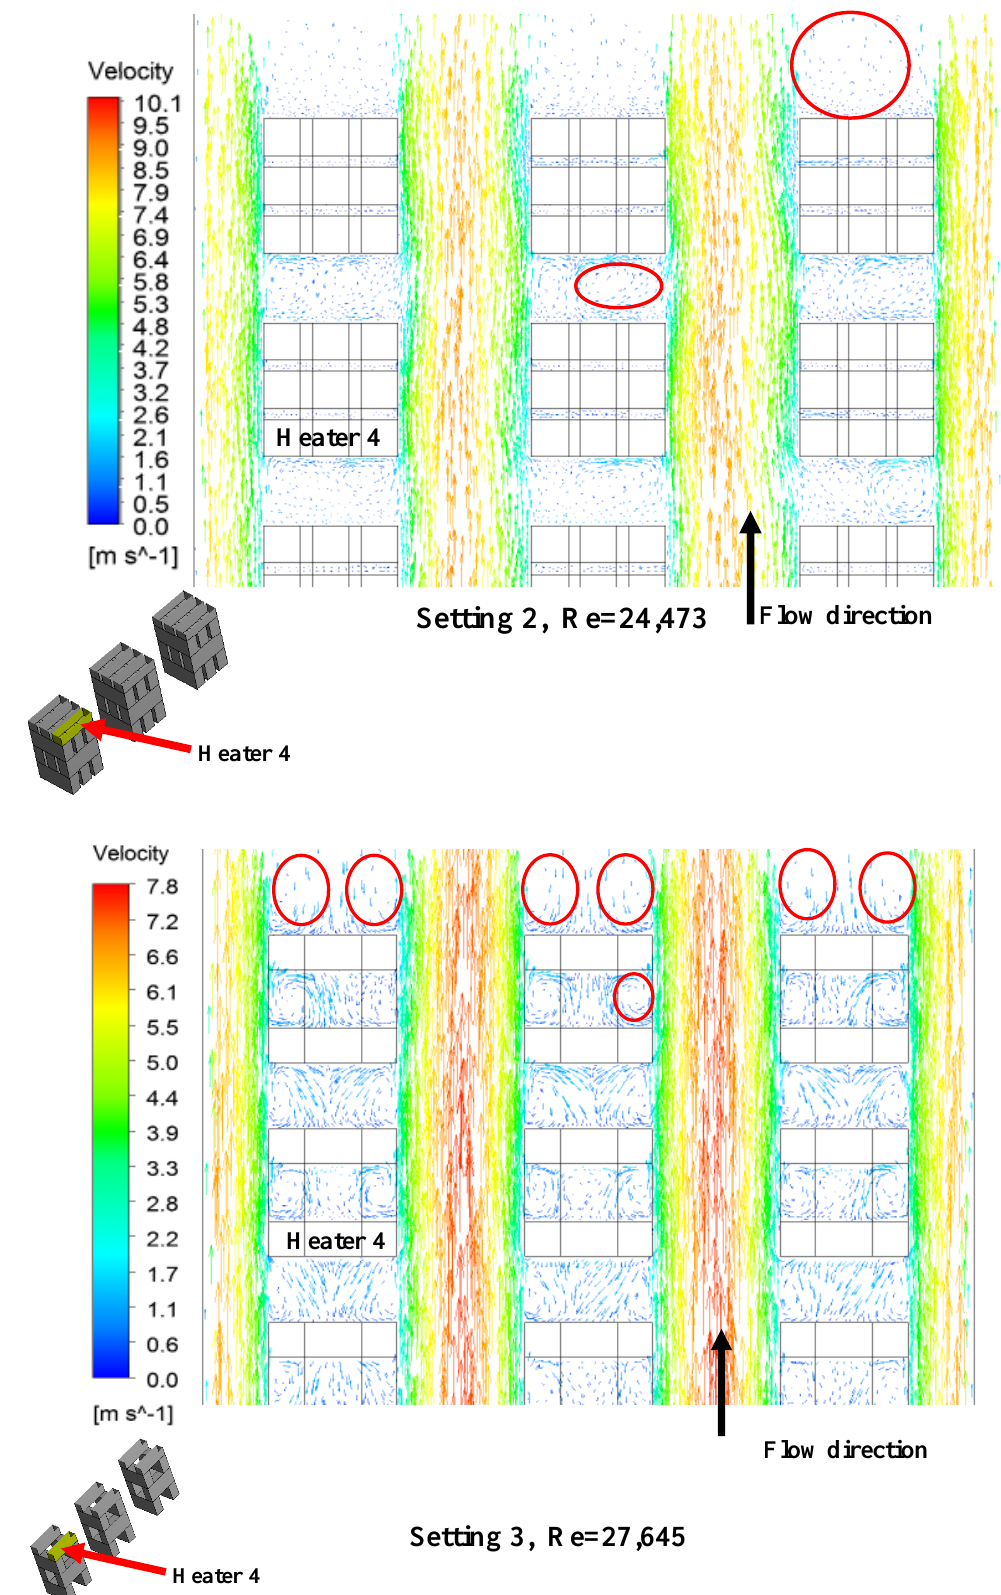
Figure 11. Velocity vectors in close-up view between fifth and sixth rows of a plane (Top 4) passing through transversal heater 4, Settings 2 and 3.